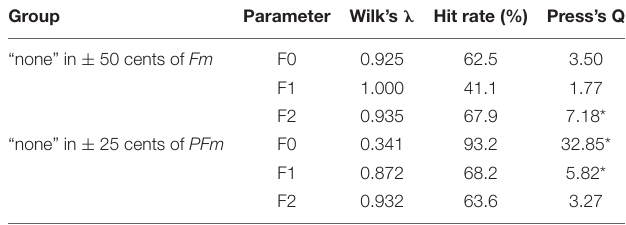
TABLE 5 | Summary of the results of post hoc analyses on significant effect of modification size for F2 in both PFm (upper panel) and Fm (lower